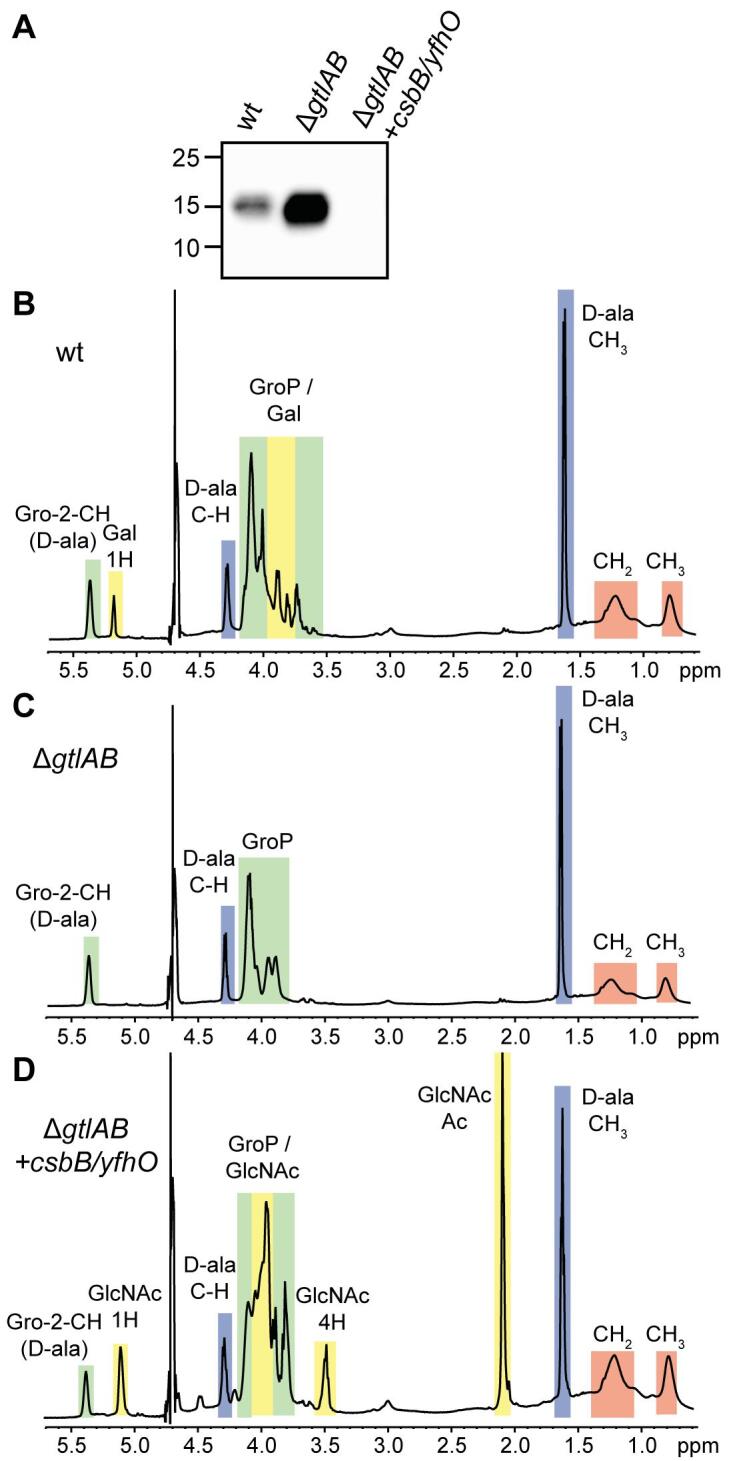
LTA in L. monocytogenes 10403S is glycosylated with GlcNAc residues upon expression of B. subtilis CsbB and YfhO. (A) Detection of LTA by western blot. Cell extracts of L. monocytogenes strains 10403S (wt), 10403SΔgtlAB and 10403SΔgtlAB + csbB/yfhO were prepared and separated on a 15% SDS-PAGE gel. Samples were standardised based on culture OD600 readings as described in the methods section. LTA was detected by western blot using a polyglycerolphosphate-specific monoclonal antibody. (B–D) NMR spectra of LTA isolated from L. monocytogenes strains (B) 10403S, (C) 10403SΔgtlAB or (D) 10403SΔgtlAB + csbB/yfhO. Colored boxes and labels indicate nonexchangeable protons derived from the different LTA components. Peaks were assigned as previously described (Wörmann et al., 2011, Morath et al., 2001, Morath et al., 2002a, Morath et al., 2002b). The spectra are representatives of three independent experiments.